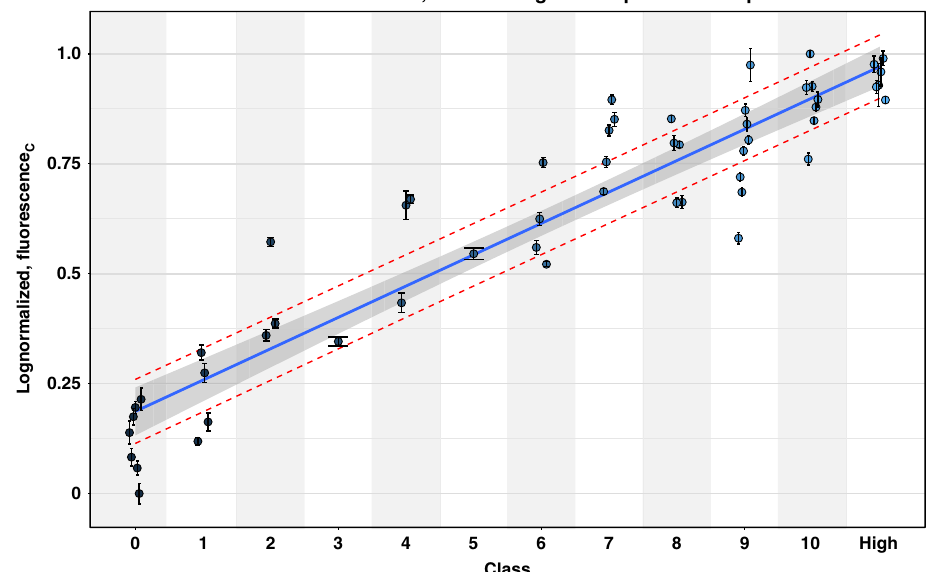
Fig. 5 Promoter transcription initiation frequency (TIF) of 54 forward engineered sigma factor 70 ( σ 70 ) promoters in function of their predicted class. Values are corrected fl uorescence measurements ( fl uorescence C ), logarithmic transformed and normalized between 0 and 1. Data are represented as mean values + / − the standard deviation derived from eight biological replicates. The linear regression line ( R 2 = 0.876) is depicted together with the 95% con fi dence interval (shaded area) and the 50% prediction interval (red dashed lines). Source data are provided as a Source Data fi le.